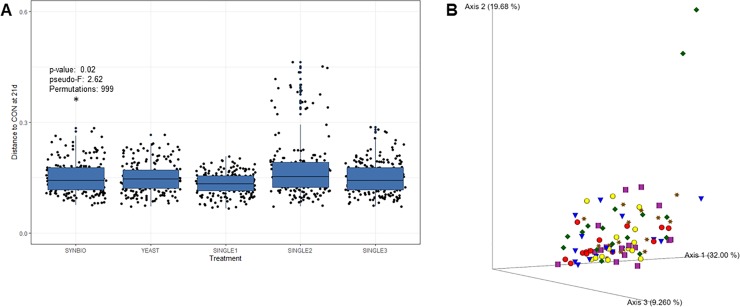
Quantitative and qualitative diversity measures of cecal microbiota in broilers at 21 days of age.(A) Pairwise comparison based on weighted Unifrac distances between cecal microbial communities from broilers fed a basal diet with no treatment (CON), synbiotic (SYNBIO), yeast-based probiotic (YEAST), or single-strain formulations composed of Bacillus amyloliquefaciens (SINGLE1), B. subtilis (SINGLE2), and B. licheniformis (SINGLE3) by 21d. (B) Principal coordinate analyses plot of cecal samples derived from unweighted UniFrac (CON- red sphere, SYNBIO- dark orange star, YEAST- purple cylinder, SINGLE1- yellow sphere, SINGLE2- green diamond, and SINGLE3- blue cone).